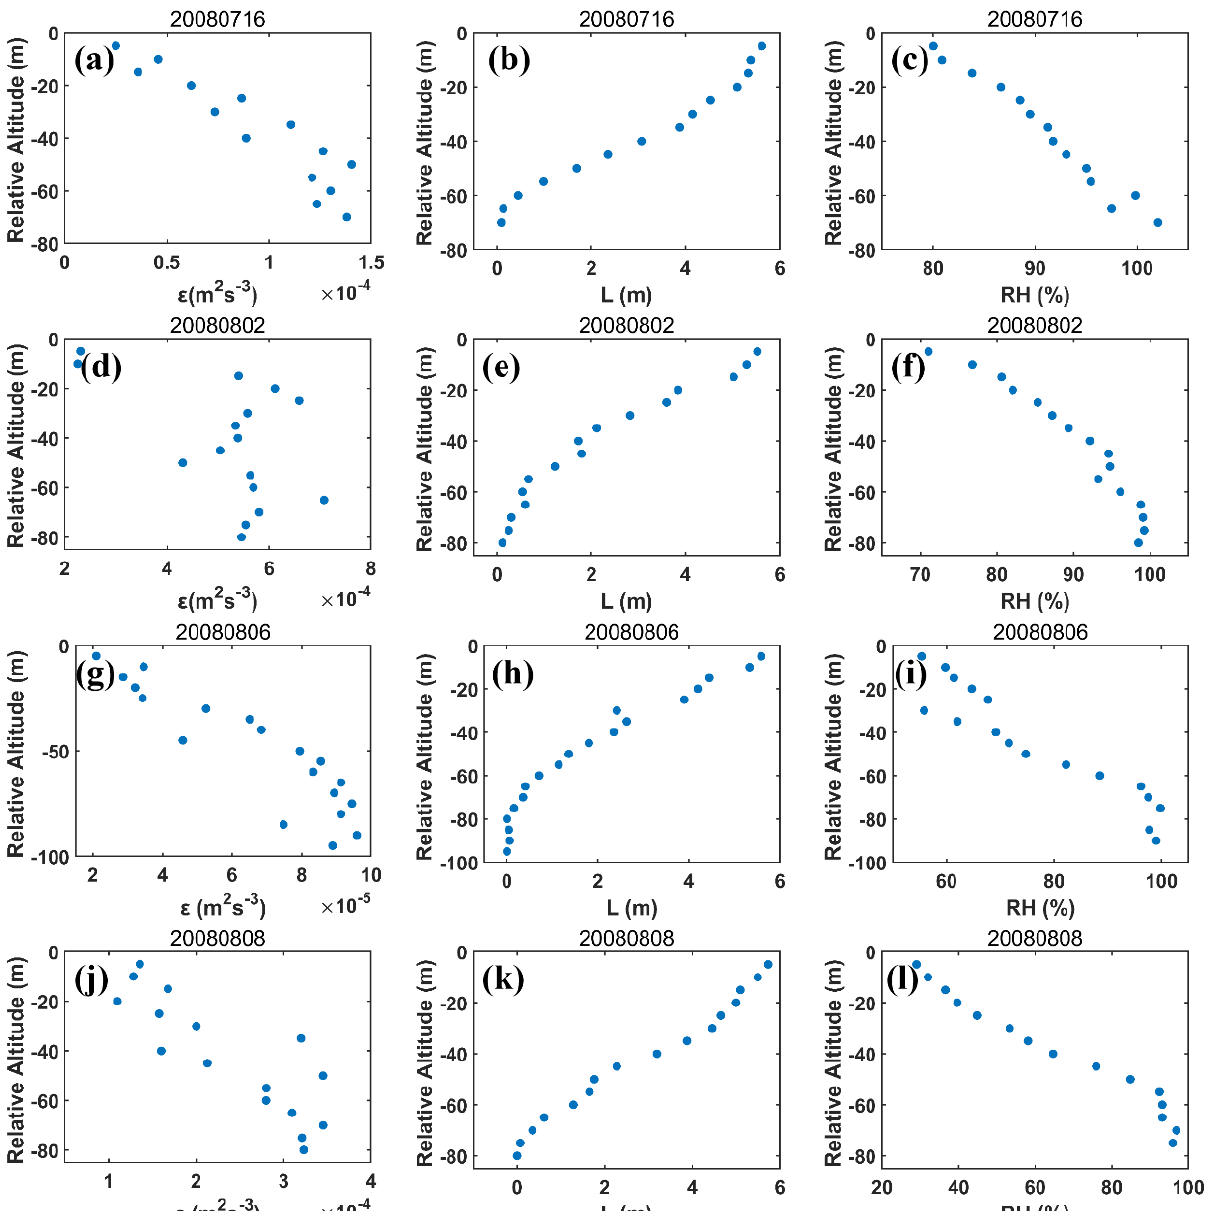
Figure 10. Height dependence of dissipation rate ( ε ) on (a) 16 July 2008, (d) 2 August 2008, (g) 6 August 2008 and (j) 8 August 2008; height dependence of relative humidity (RH) of droplet-free air on (b) 16 July 2008, (e) 2 August 2008, (h) 6 August 2008 and (k) 8 August 2008; and height dependence of length of droplet-free air ( L ) on (c) 16 July 2008, (f) 2 August 2008, (i) 6 August 2008 and (l) 8 August 2008. The relative altitude on the y axis equal to 0 represents the cloud